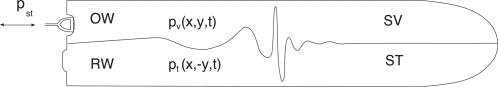
Uncoiled cochlea.Emergence of a travelling wave on the BM due to a sinusoidally varying sound wave with stapes amplitude pst (OW: oval window, RW: round window, ST: scala tympani, SV: scala vestibuli).